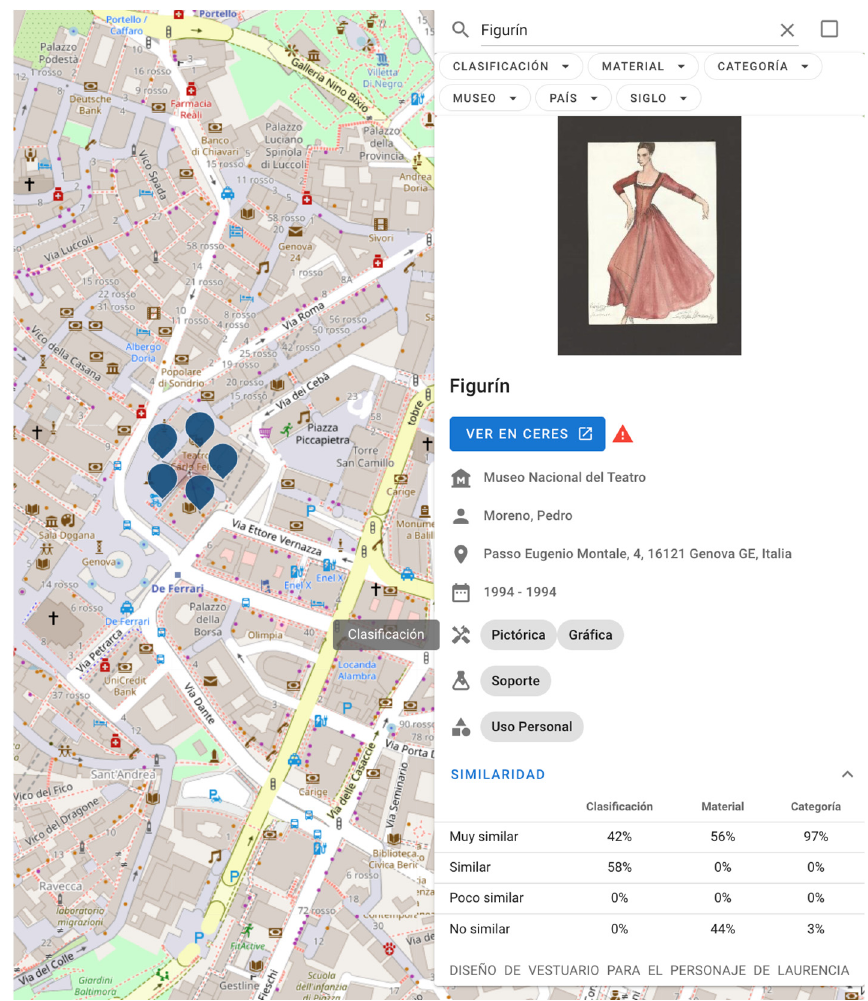
Figure 7. The side-bar gallery showing the information about one of the objects.